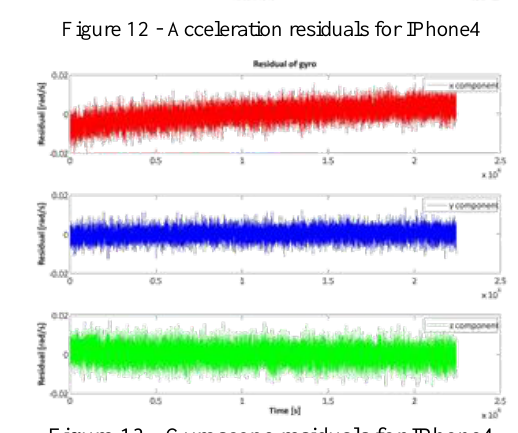
Figure 13 - Gyroscope residuals for IPhone4